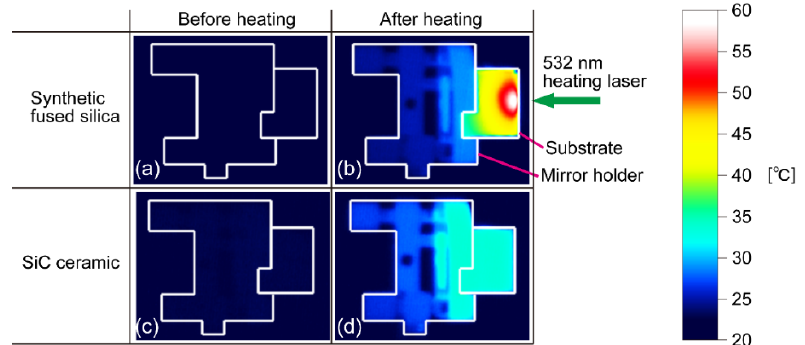
Figure 2. Temperature distributions of substrates in the mirror holder are measured from the lateral side with a thermography camera. Temperature distributions of the synthetic fused silica substrate ( a ) before laser irradiation and ( b ) after 20 min laser irradiation. Temperature distributions of the SiC ceramic substrate ( c ) before laser irradiation and ( d ) after 20 min laser irradiation. White lines show the border of the substrate and the mirror holder as a visual guide. The peak temperatures in ( b ) and ( d ) are 60 and 33 ◦ C, respectively.